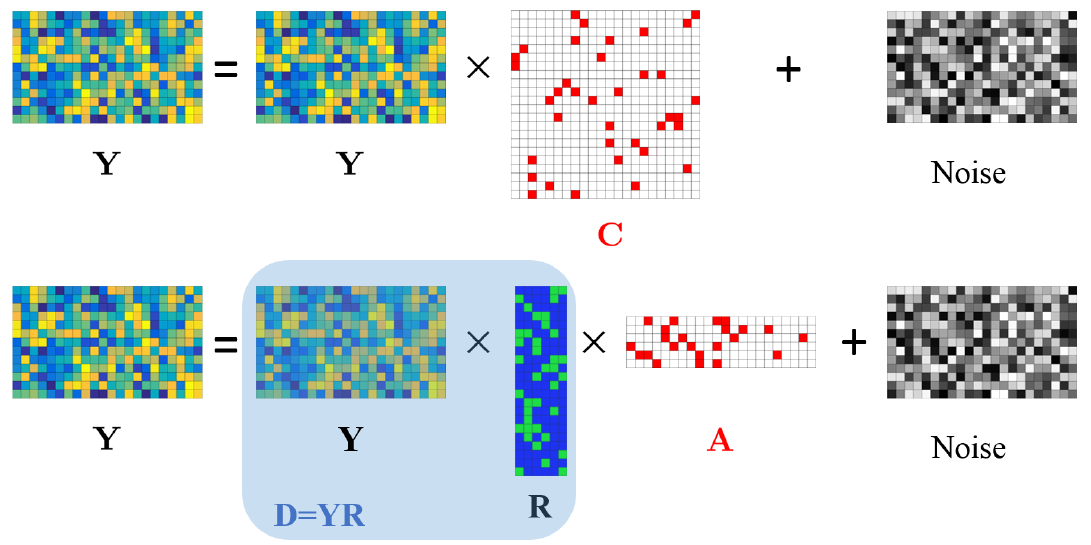
Figure 2. Illustration of the traditional SSC-based models (top) and the sketched SSC model (bottom) where C and A are two sparse coefficient matrices to be computed and R is a random matrix for